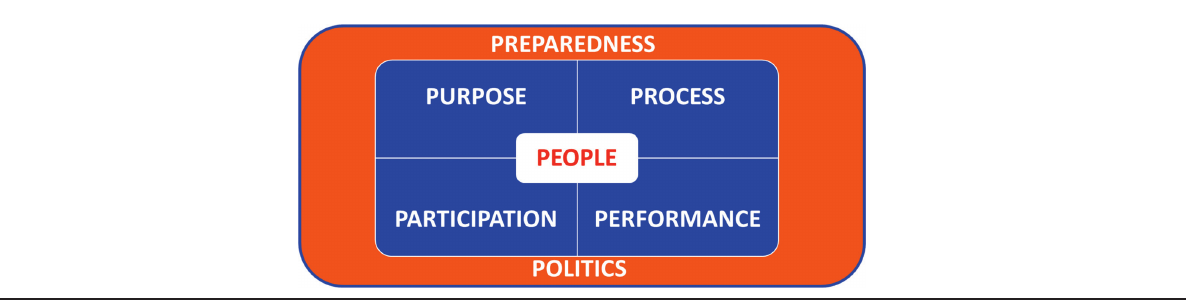
Figure 1. The engaged research design framework (Source: Holliman et al.,